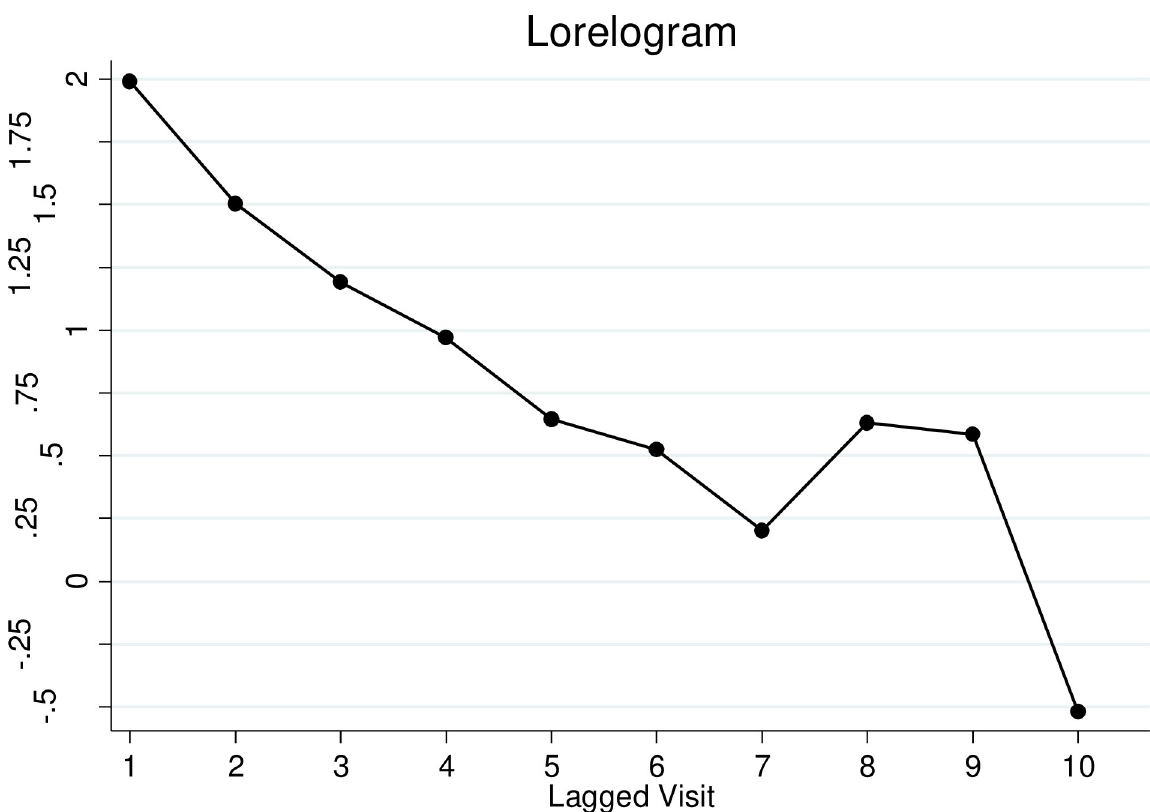
Fig 1. Lorelogram. The x-axis is the time-lag between two measurements and the y-axis is log odds ratio.